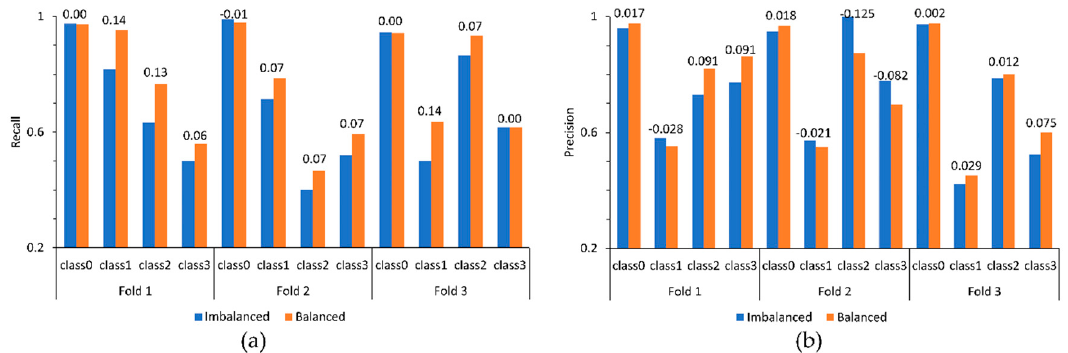
Figure 17. Changes in recall ( a ) and precision ( b ) observed for three different compositions of training and testing sets (figures on the top of the bars are the corresponding differences; see the main text for details).